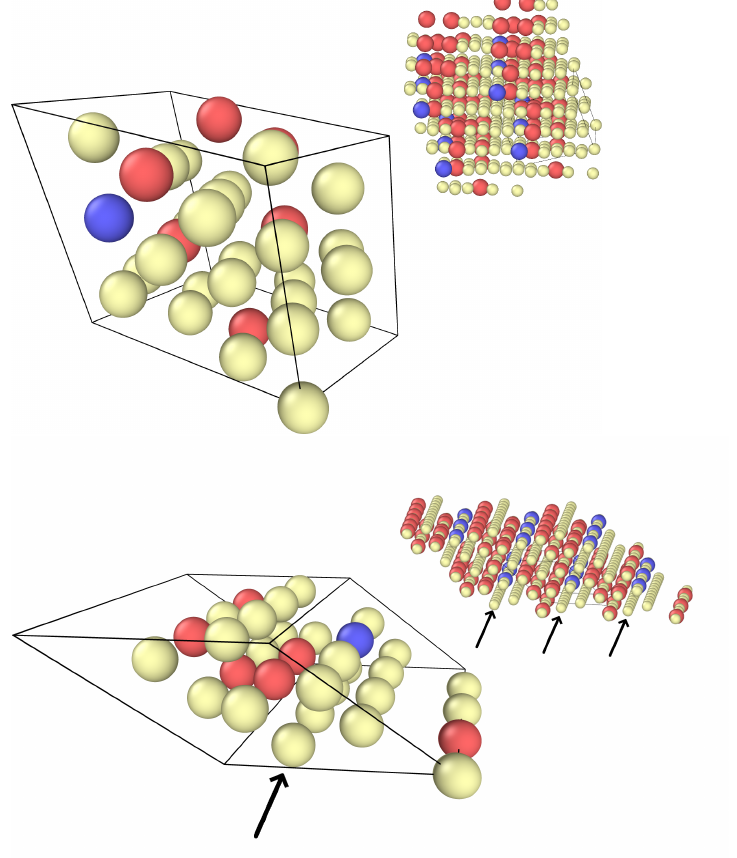
Figure 3. The two special quasirandom structures with composition Ni 25 Cr 6 X; Ni atoms in yellow, Cr atoms in red, alloying element in blue. The smaller pictures show a periodically repeated pattern, arrows in the second picture mark close-packed planes that do not contain Cr